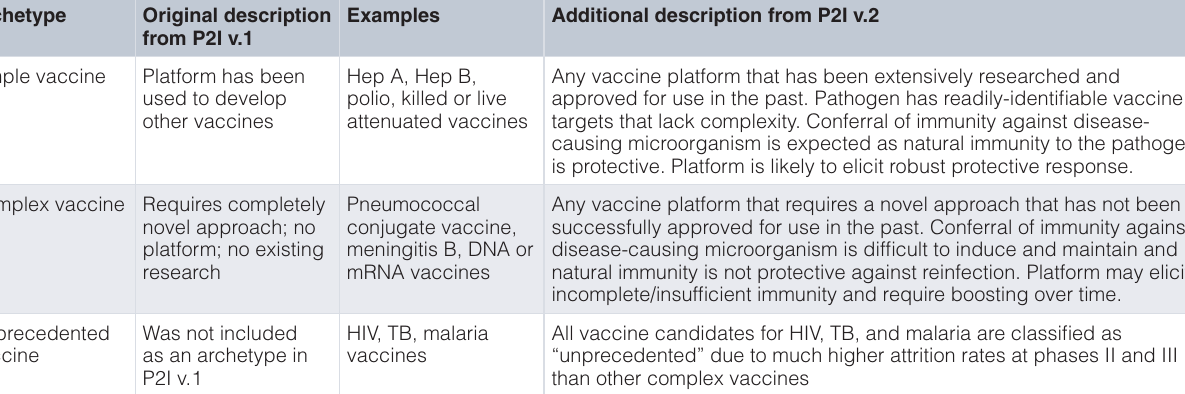
Table 2. Classification of vaccine candidates into archetypes (based on references 1 and 2; published under CC-BY 4.0). Archetype